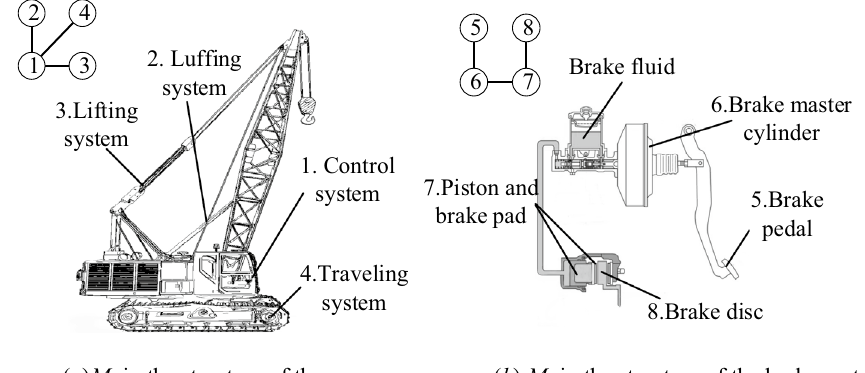
Figure 16. Motifs in common mechanical